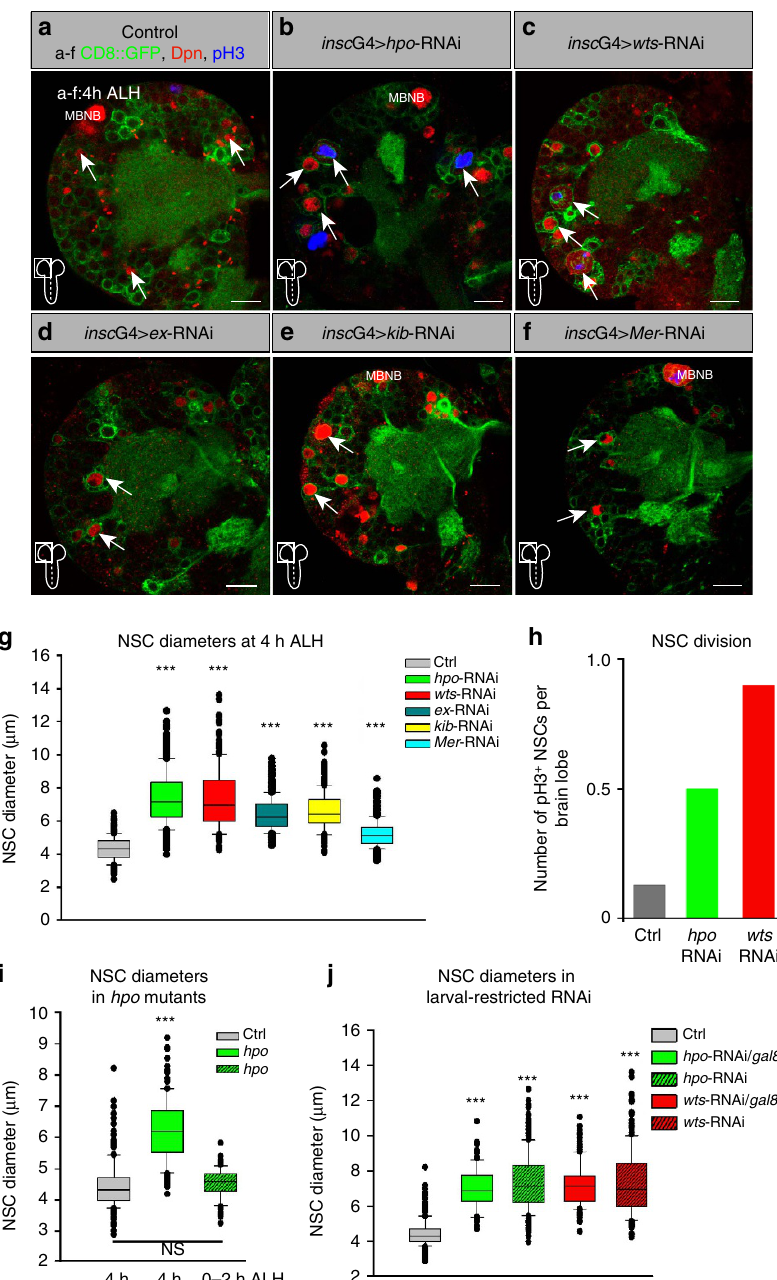
Figure 1 | The SHW signalling pathway maintains quiescence in larval NSCs. ( a ) Wild-type larval brain lobe ( insc G4 4 UAS-CD8::GFP, Control) 4h ALH. Quiescent NSCs are small in cell size. NSCs of the mushroom body (MBNB) are big in cell size. No pH3-positive NSCs can be observed. ( b - f ) NSC-specific RNAi ( insc G4 4 UAS-CD8::GFP and respective construct) of hippo ( hpo )( b ), warts ( wts )( c ), expanded ( ex ) ( d ), kibra ( kib ) ( e ) or Merlin ( Mer ) ( f ) leads to premature cell growth and cell division (observed in hpo and wts -RNAi) of NSCs. Arrows depict examples of NSCs. ( g , h ) Quantification of NSC cell diameters ( g ) and proliferation ( h ) in RNAi for Hippo pathway components. ( g ) *** P o 0.001. Wilcoxon rank sum test. Median and s.d. were calculated from two biological replicates. Control n ¼ 355 NSCs (7 brain lobes); insc G4 4 hpo -RNAi, n ¼ 575 NSCs (11 brain lobes); insc G4 4 wts -RNAi, n ¼ 236 NSCs (5 brain lobes); insc G4 4 expanded -RNAi, n ¼ 400 NSCs (8 brain lobes); insc G4 4 kibra -RNAi, n ¼ 266 NSCs (5 brain lobes); insc G4 4 Mer -RNAi, n ¼ 506 NSCs (10 brain lobes); all 4h ALH. ( h ) Number of NSCs in mitosis (pH3-positive) at 4h ALH per brain lobe in wild-type (7 brain lobes) and hpo - and wts - RNAi (11 or 5 brain lobes). ( i ) Quantification of NSC cell diameters in hpo JM1 / hpo KC202 ( hpo in figure) trans-heterozygous mutants at 0–2h ALH and 4h ALH. *** P o 0.001. Wilcoxon rank sum test. Median and s.d. were calculated from two biological replicates. Control 4h ALH, n ¼ 150 NSCs (3 brain lobes); hpo JM1 / hpo KC202 0-2hmin ALH, n ¼ 65 NSCs (2 brain lobes); hpo JM1 / hpo KC202 4h ALH, n ¼ 121 NSCs (3 brain lobes). ( j ) Quantification of NSC diameter of larval-restricted RNAi of hpo ( n ¼ 120 NSCs in 8 brain lobes) and wts ( n ¼ 172 NSCs in 10 brain lobes) in NSCs using the GAL80ts system. For comparison hpo - and wts -RNAi measurements without GAL80ts are added. All images are single focal planes, anterior up; Scale bar, 10 m m. NSC in red (Deadpan), CD8::GFP in green and phosphohistone H3 in blue (pH3). Pictograms denote the area of the brain shown in the picture. See also Supplementary Fig.